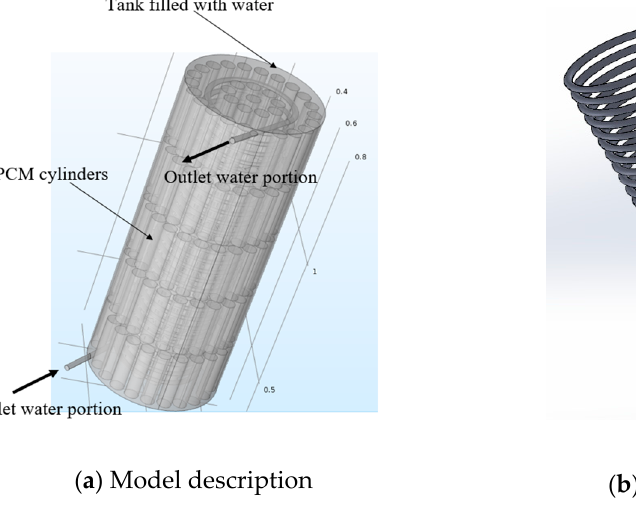
Figure 2. Numerical model description. Table 2. PCM